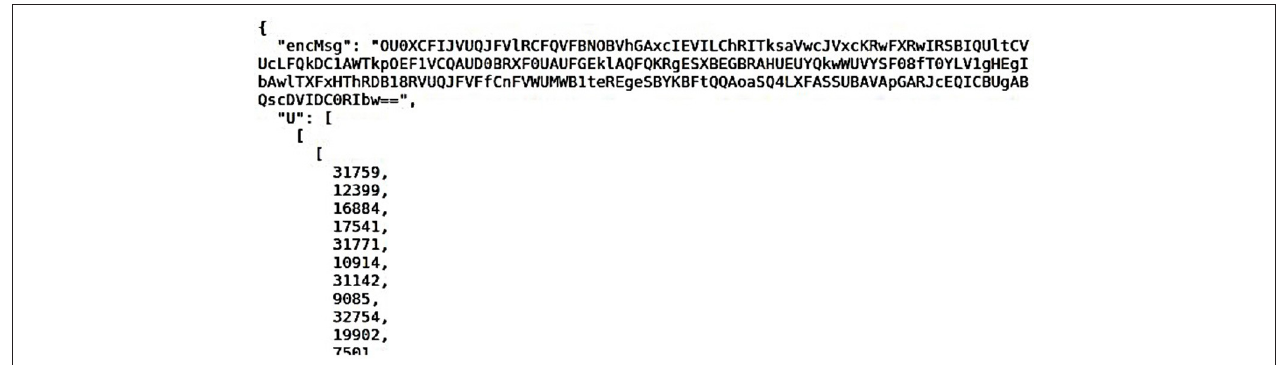
FIGURE 4 | Ciphertext received by website after JSON parse (only a portion is shown in this figure).